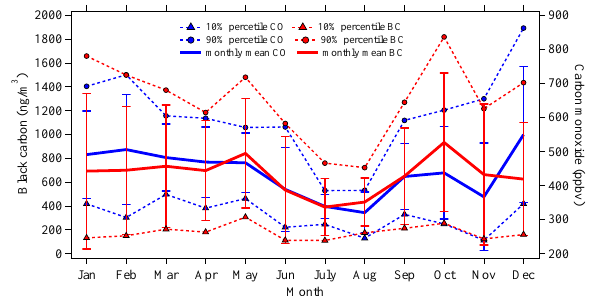
Fig. 2. Seasonal variations in BC (red) and CO (blue) concentra- tions during the observation period. Circles and triangles represent 90% and 10% percentiles of hourly mean BC and CO concentra- tions respectively. Error bars are also plotted in the figure to indicate monthly